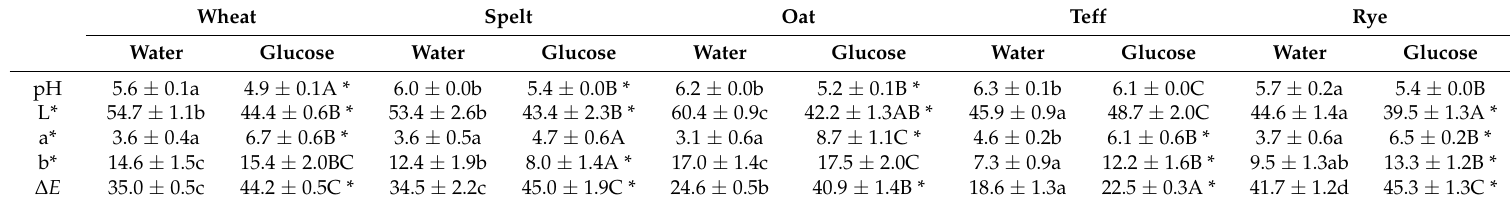
Table 2. Colour parameters and pH of baked doughs formulated with water or glucose and wheat, spelt, oat, teff and rye flour. Wheat Spelt Oat Teff Rye Water Glucose Water Glucose Water Glucose Water Glucose Water Glucose